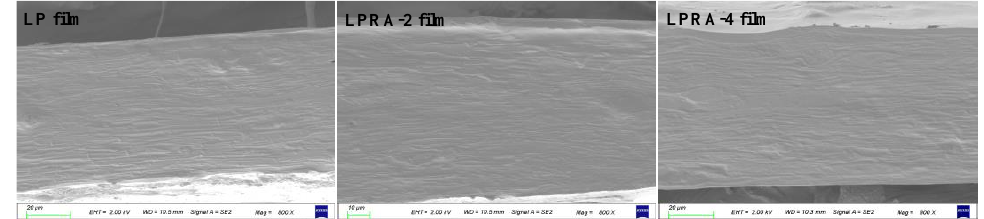
Figure 1. Cross-sectional micrographs of LP film, LPRA-2 film and LPRA-4 film.